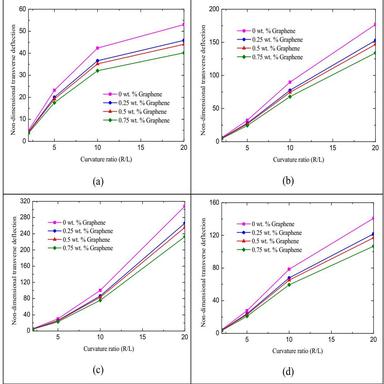
The non-dimensional deflection of the GFRP panels with various wt% of graphene reinforcement under SSL. (a) CCCC (b) CFCF (c) SFSF (d) SSSS.